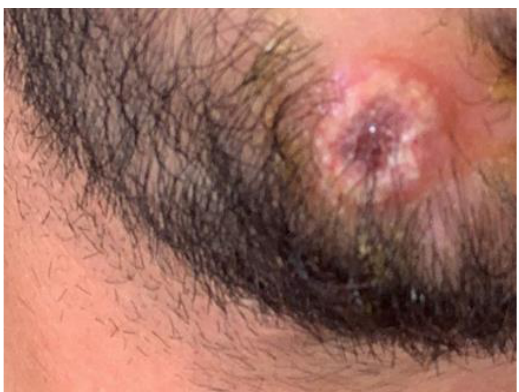
Figure 3. Clinical characteristics of patient 2 reported in this paper: note a single oval ulcerative lesion of the chin similar to the lesions of patient 1.